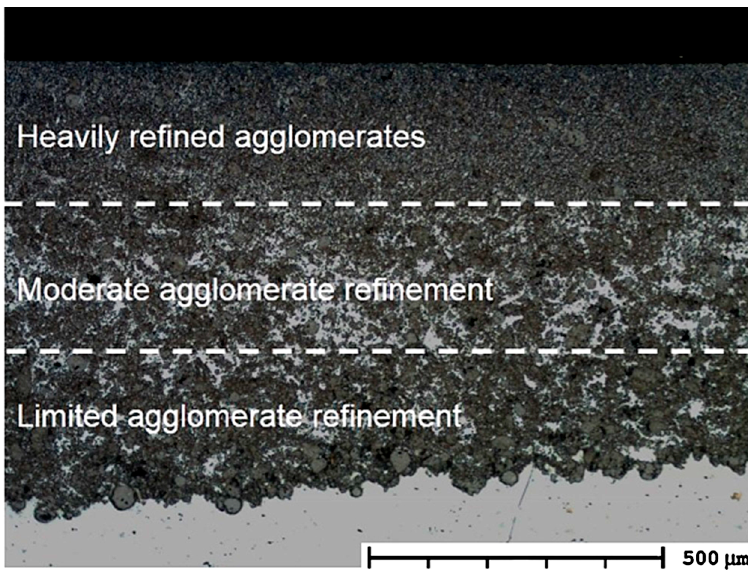
Figure 11. Variations in particle refinement through the depth of spray stirred MMC (adapted from reference [56] , with permission from © Elsevier).